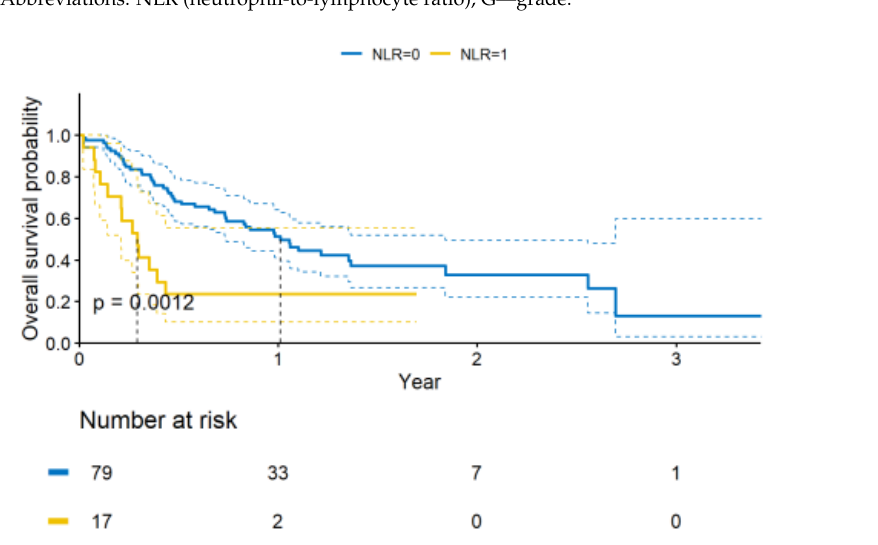
Table 4. Univariate and multivariate analysis of overall survival for the entire population.